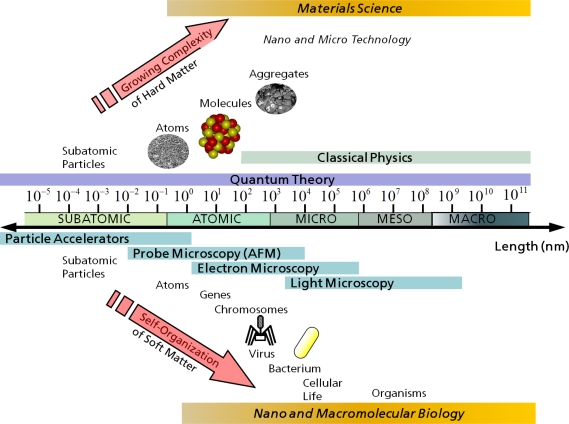
Schematic comparing the relevant length scales in materials science according to [3]. In the field of nano- and microtechnology one usually tries to approach the molecular level from larger scales, miniaturizing technical devices, whereas nature itself always seems to follow a bottom-up approach, assembling and self-organizing its complex (soft) structures from the atomic scale to complex cellular organisms. The typical scopes of important experimental methods using microscopes is displayed as well. The validity of classical physics is limited to length scales down to approximately the size of atoms which, in classical numerical schemes, are often treated as point particles or spheres with a certain eigenvolume.